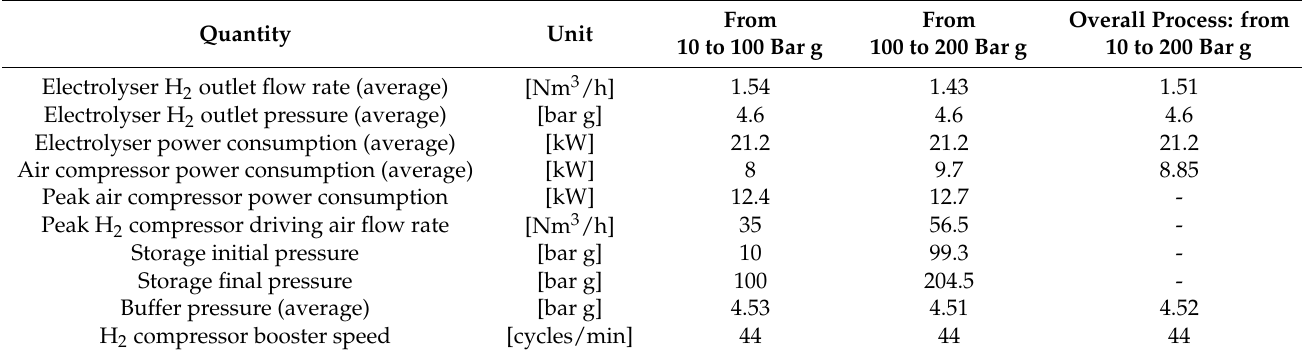
Table 11. Test results for tests with electrolyser operating at 4.6 bar and hydrogen compressor running at 44 cycles per